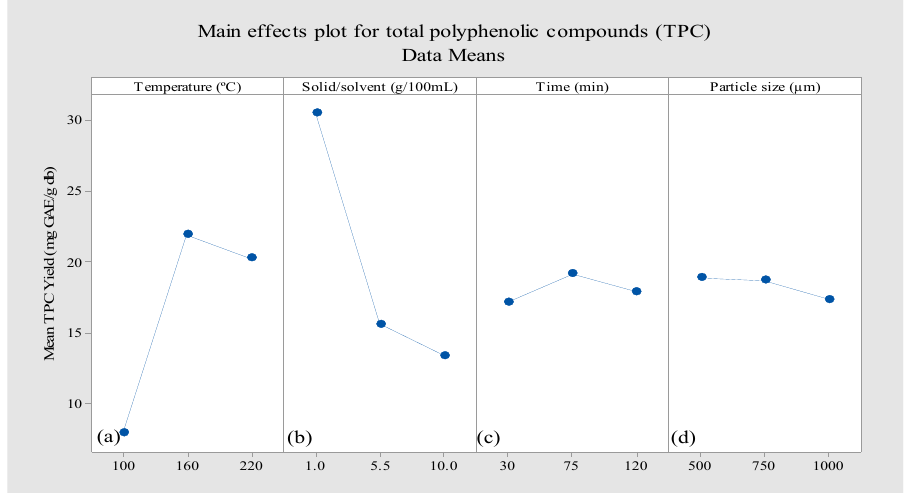
Figure 1. The independent effects of the process parameters of ( a ) temperature (°C), ( b ) solid-to- solvent ratio (g/100 mL), ( c ) time (min), and ( d ) mean sample particle size (µm) on TPC content of apple pomace extract using subcritical water extraction.